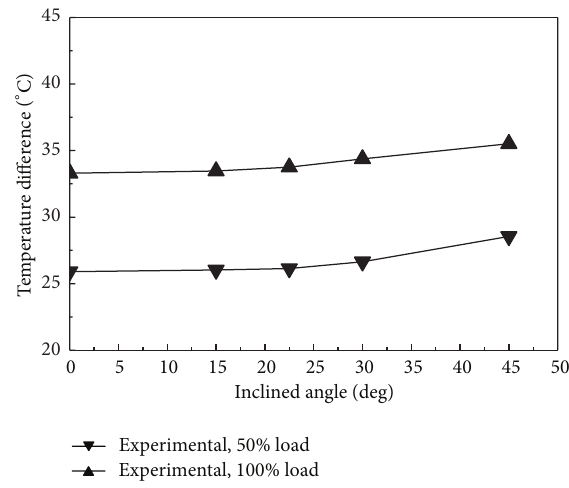
Figure 2: Total mass flow rates under different inclined angle. positions throughout the entire test loop, including the inlets and outlets of EH, SG, and the heat exchanger.